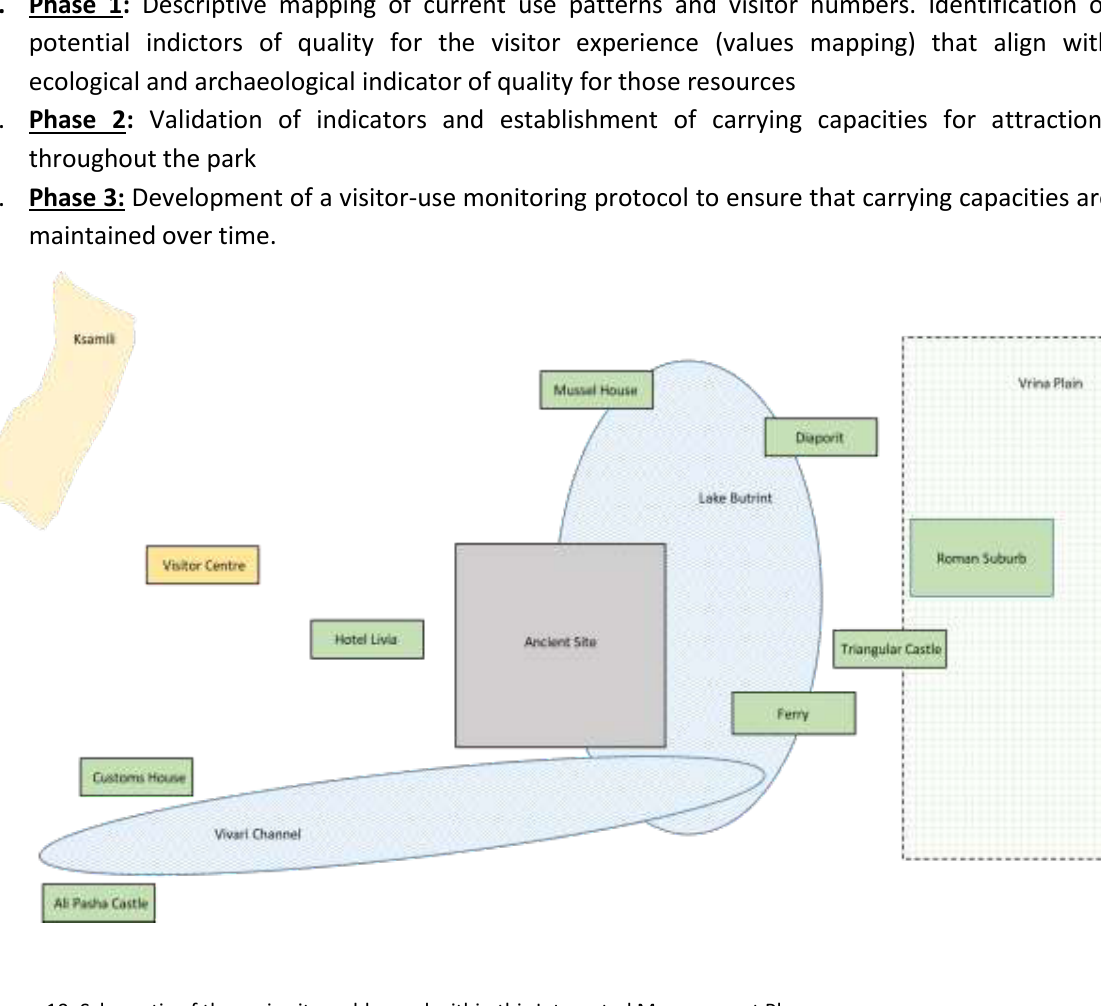
Figure 10: Schematic of the main sites addressed within this Integrated Management